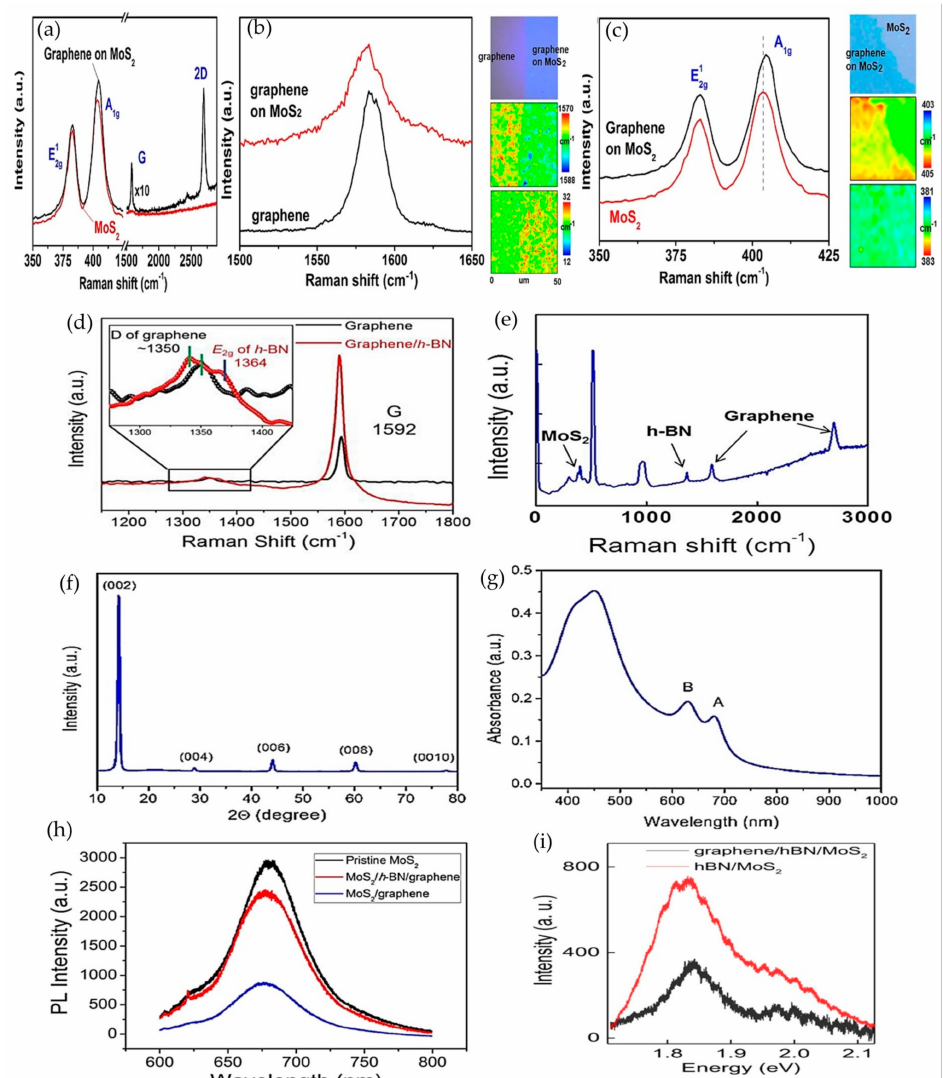
Figure 10. Raman spectra of ( a ) graphene/MoS 2 heterostructure with comparison to ( b ) monolayer graphene, ( c ) monolayer MoS 2 (Reproduced with permission from [32], Published by Springer Nature, 2014), ( d ) h-BN/graphene (Reprinted from [10], with permission from Elsevier, 2019) and ( e ) MoS 2 /h-BN/graphene light (Reprinted with permission from [47], American Chemical Society, 2017). Characterization of V–MoS 2 nanosheets with ( f ) XRD diffraction pattern and ( g ) UV–Vis absorption spectrum (Reprinted from [61], with permission from Elsevier, 2019). Photoluminescence spectrum of ( h ) pristine MoS 2 , MoS 2 /h-BN/graphene and MoS 2 /graphene heterostructure to denote the dynamics of photogenerated electrons (Reprinted from [10], with permission from Elsevier, 2019) and ( i ) graphene/h-BN/MoS 2 and h-BN/MoS 2 for optoelectronic applications (Republished with permission of IOP Publishing, Ltd., from [30]; permission conveyed through Copyright Clearance Center, Inc.,